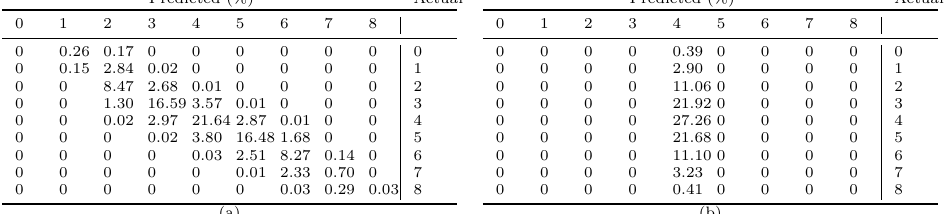
Table 3: Confusion matrix for (a) DPAcontest v4, (b) AES_RD imbalanced dataset, SVM with C = 1 , γ = 1, 10 000 measurements in the training phase and 25 000 measurements in the testing phase. Results are given in percentages. Predicted